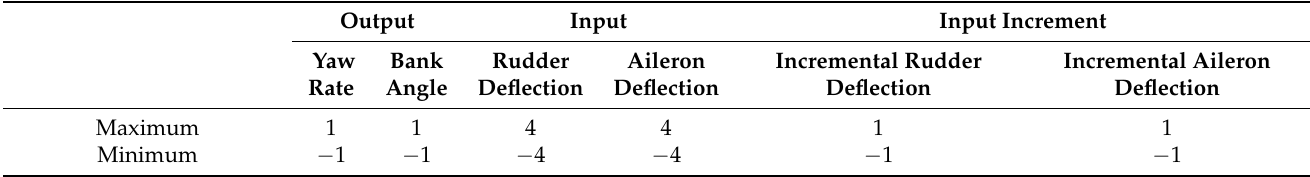
Table 1. Jet transport aircraft